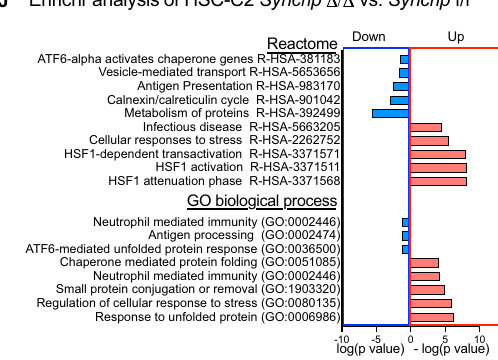
R-HSA-194315ATF6-alpha activates chaperone genes R-HSA-381183 R-HSA-111447Signaling by Rho GTPases R-HSA-392499Activation of BAD and translocation to mitochondria R-HSA-195258Metabolism of proteins R-HSA-1428517RHO GTPase Effectors Homo sapiens cycle and respiratory electron transport